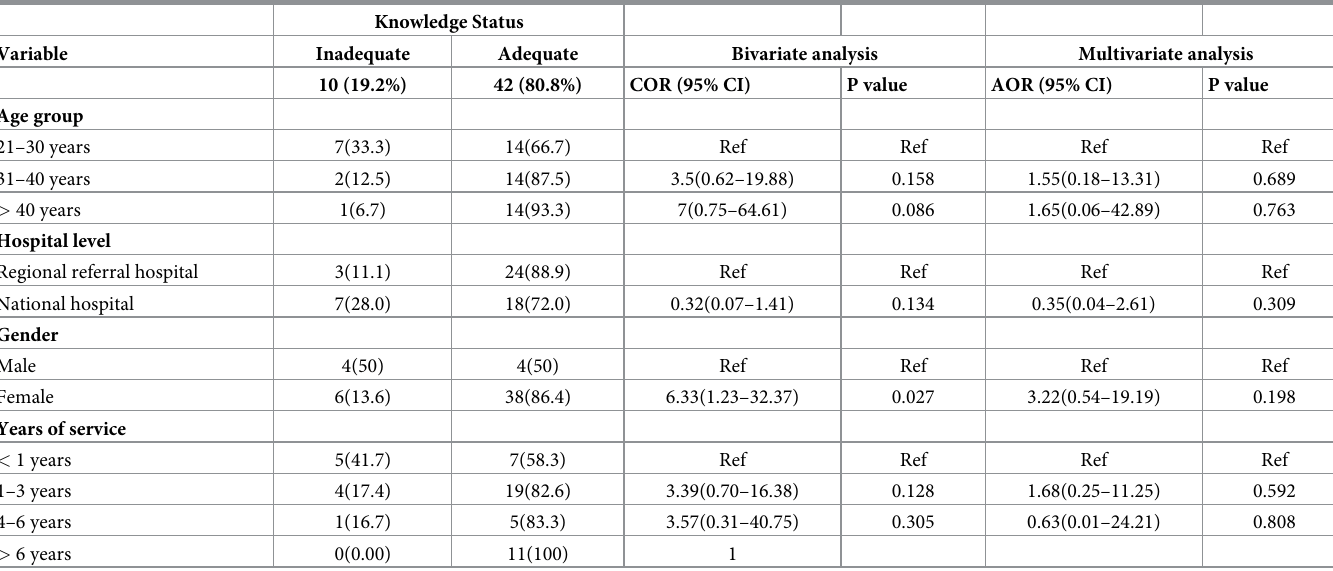
Table 2. Factors associated with nurse’s knowledge in infection prevention management using the binary logistic regression